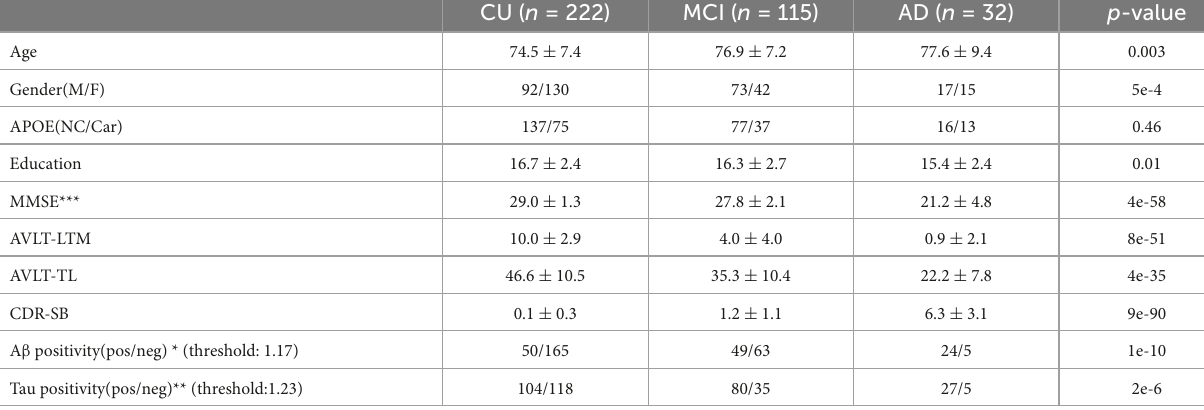
TABLE 1 Subject characteristics age, gender, APOE, education, cognitive measures as well as A β and tau positivity are included for the three groups (CU, MCI, and